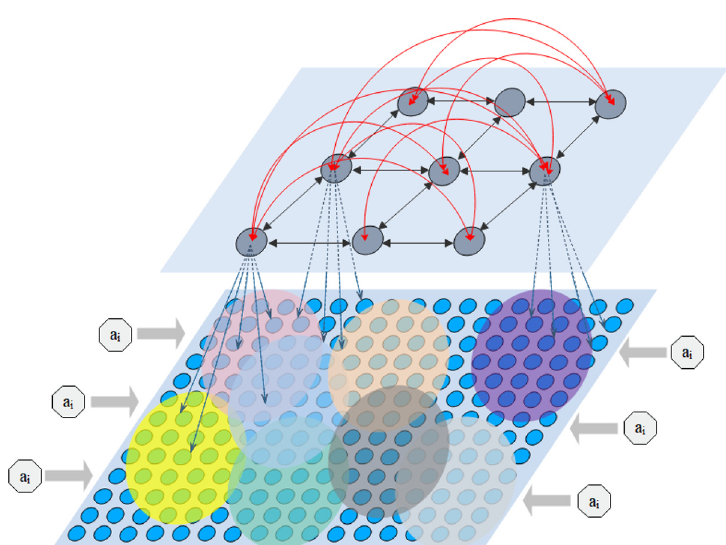
Figure 9. Member complex network